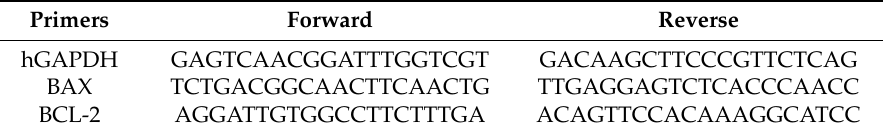
Table 3. Primers sequences used for real-time PCR